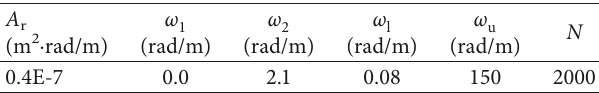
Table 2: Rail irregularity parameters used in the numerical